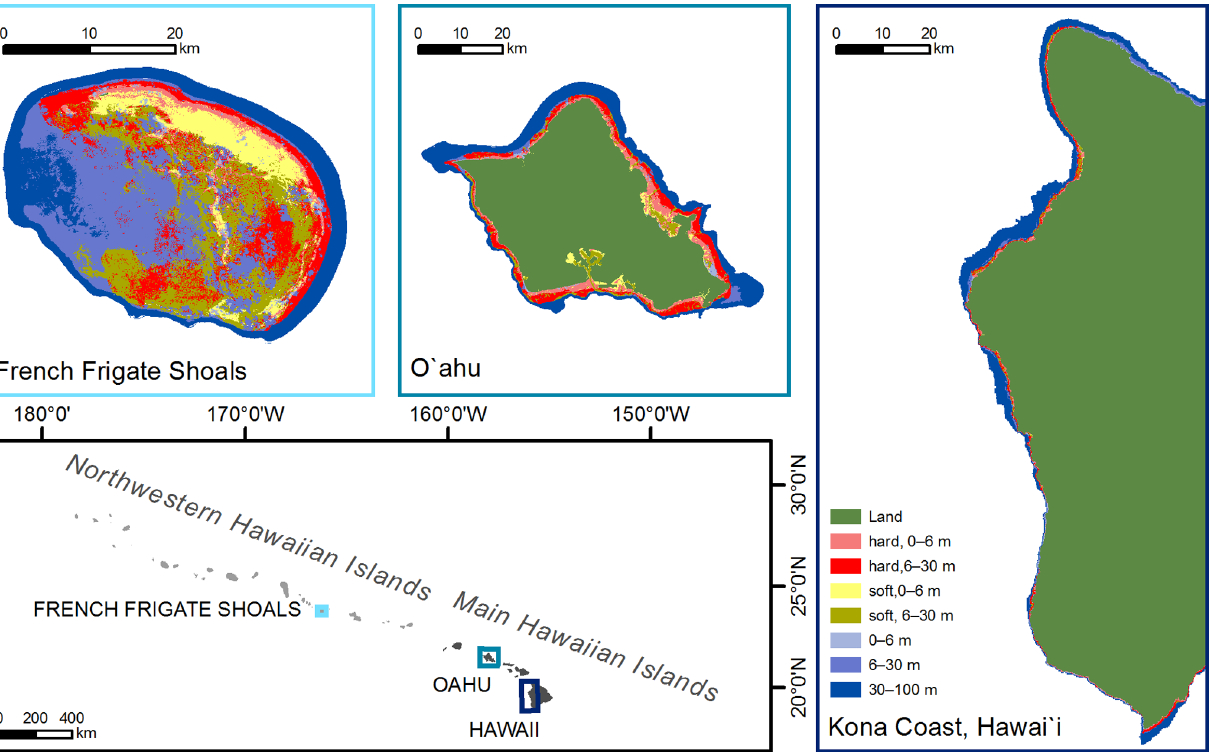
Figure 1. Habitat maps of the three modeled coral reef areas and their location in the Hawaiian Archipelago. Hard and soft in the legend indicate bottom type.